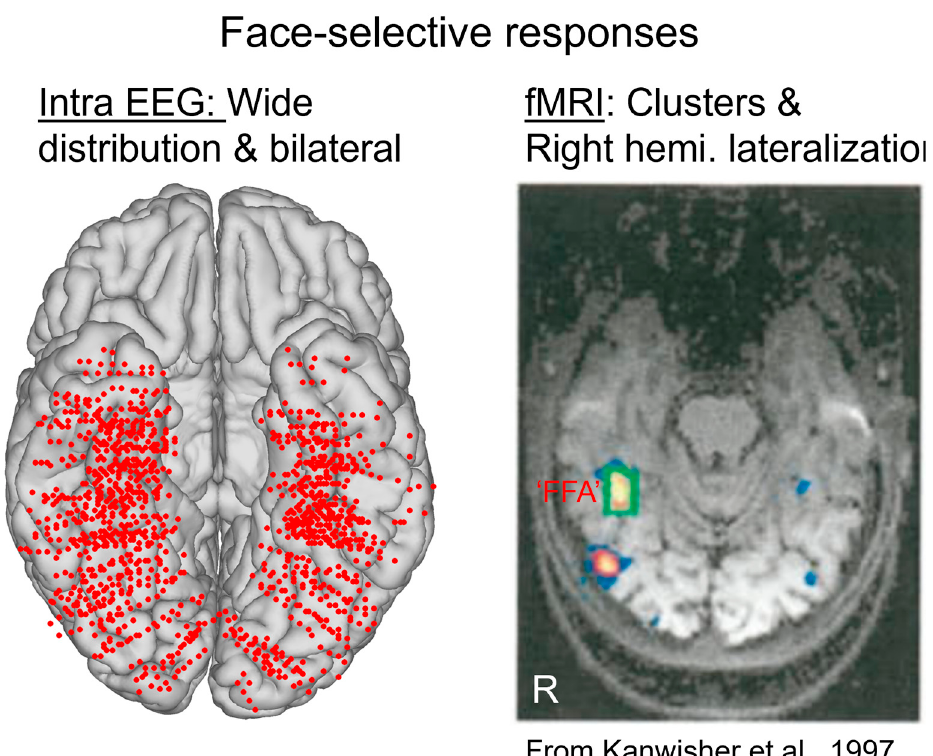
Figure 4. Illustration of the contrast between—on the left—iEEG findings of face-selective activity in the VOTC as described here, with a wide bilateral distribution (N = 84) and—on the right—the local face-selective regions, or clusters, found in fMRI (here reproduced with permission from the seminal study of Kanwisher et al., 1997 [67] usually with right lateralization.